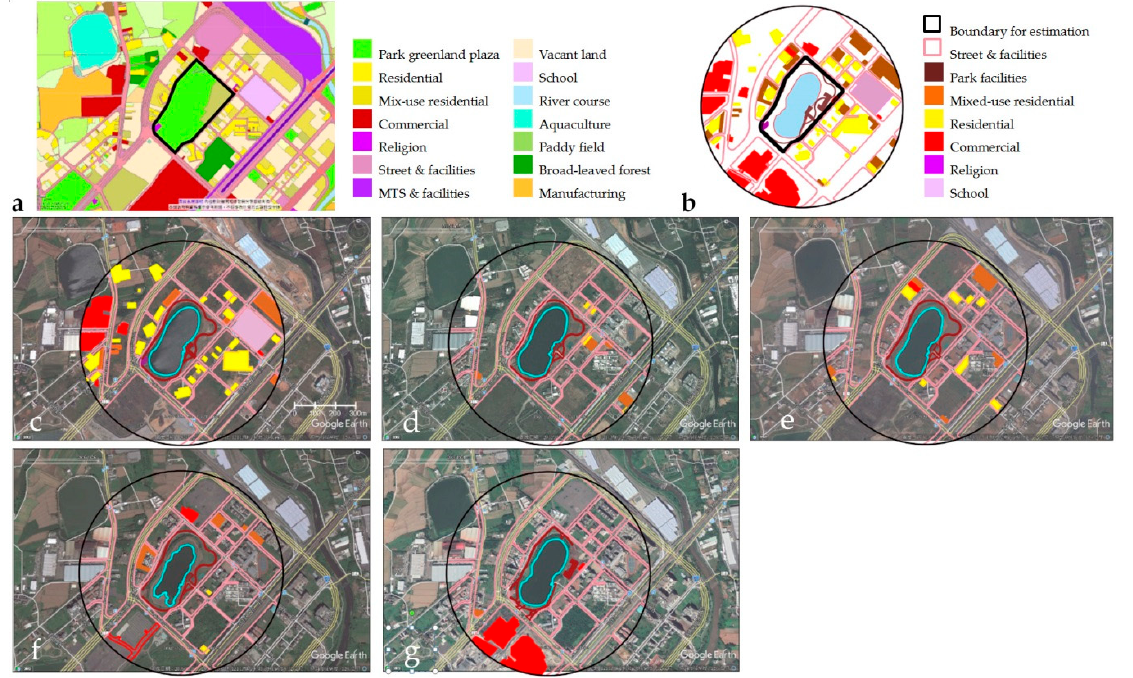
Figure 8. Land use districts ( a ) and building types ( b ) around Hengshan Calligraphy Park; highlighted area of modifications made in ( c ) 2010, ( d ) 2012, ( e ) 2014, ( f ) 2016, and ( g ) 2018.